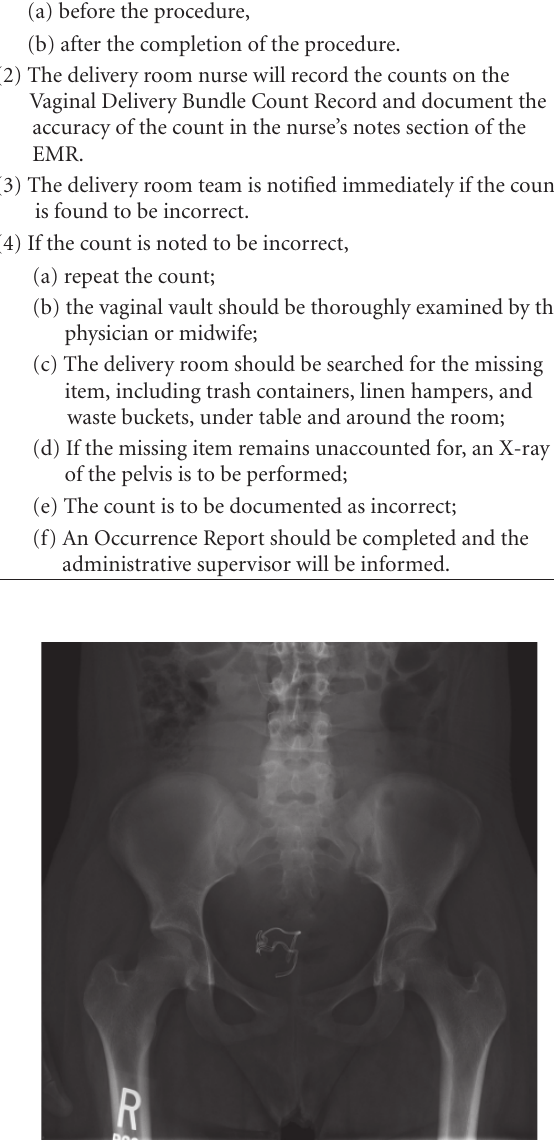
Figure 1: Postdelivery X-ray of the pelvis demonstrating two curvi- linear triangular-shaped structures composed of 2 radiopaque threads in the vaginal/rectal